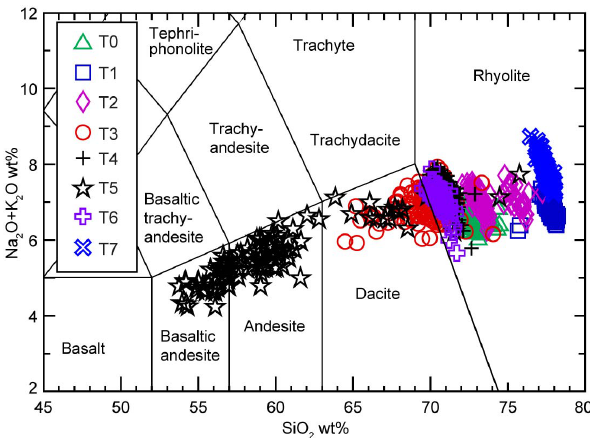
Figure 4. TAS (total alkali silica) classification diagram with fields according to Le Bas et al. (1986). All data are single shard glass analyses normalized to 100%. Data include both sets analyzed in Edmonton and